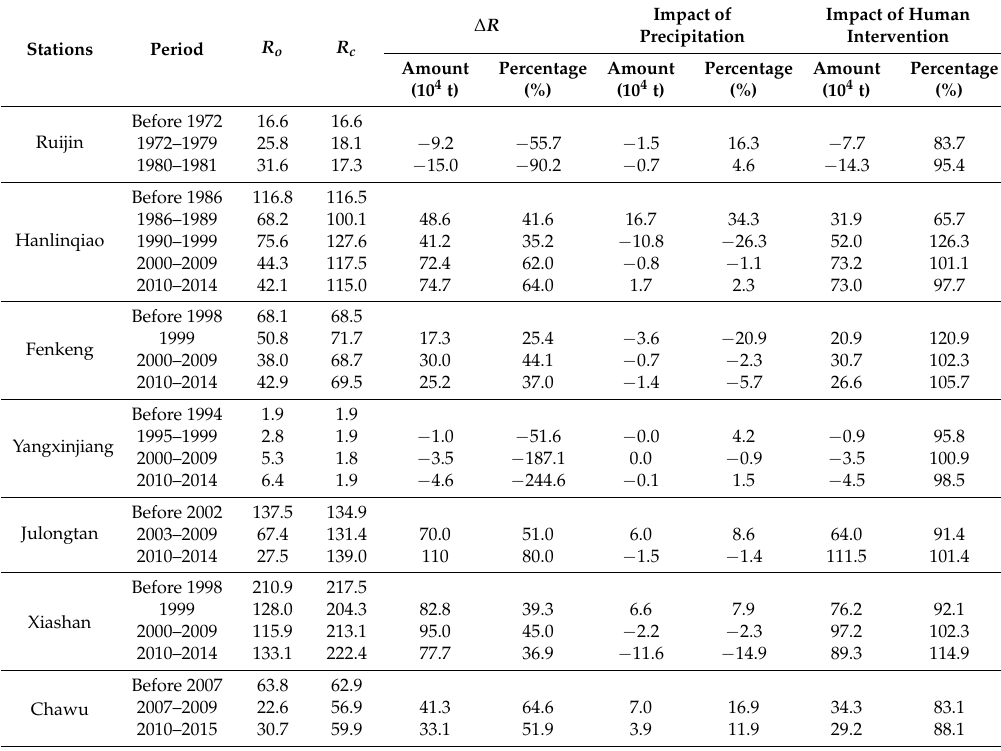
Table 5. The impact of precipitation and human intervention on sediment discharge after the change-point year at seven stations on the Gongshui River (10 4